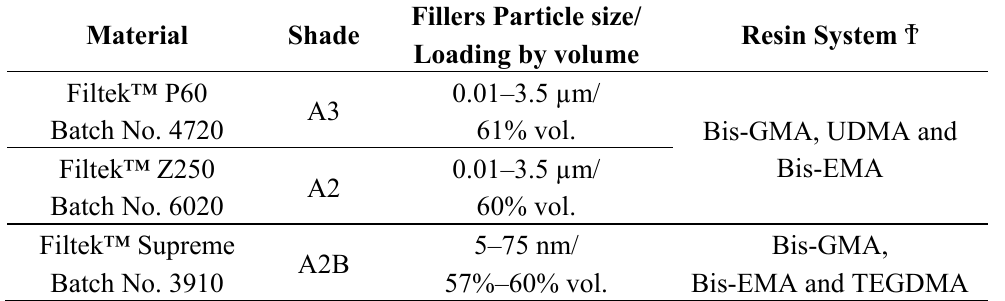
Table 1. Composition of commercial dental composites with filler particle size and loading by